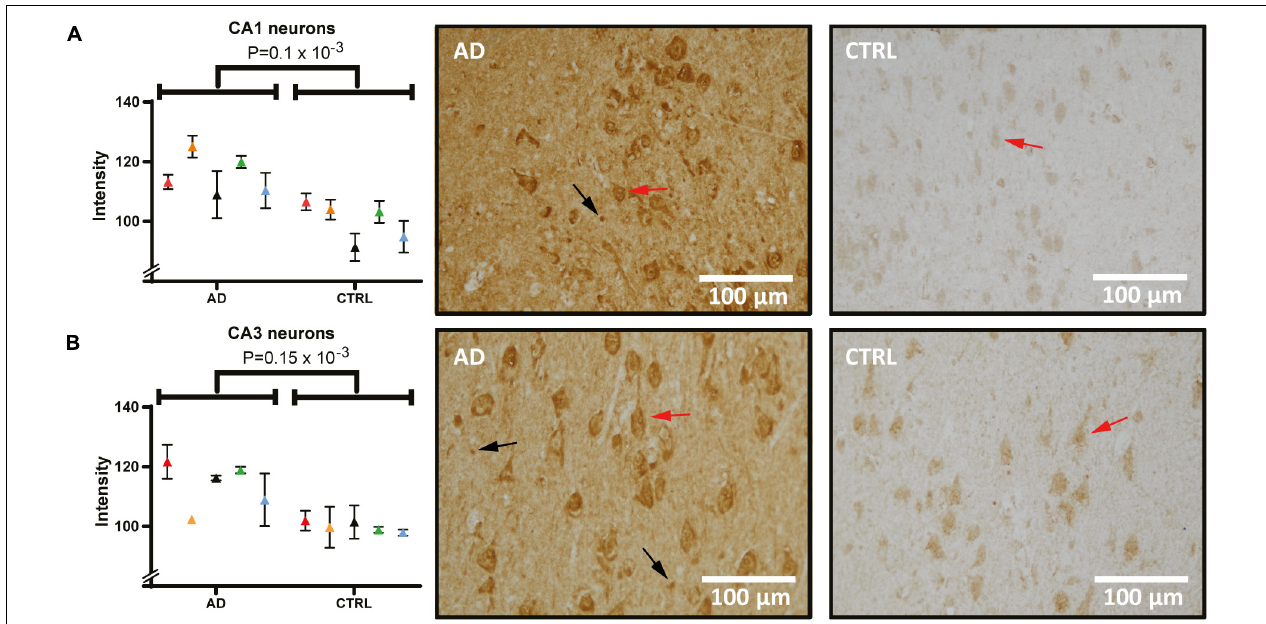
FIGURE 5 | Heat shock cognate 71 (Hsc71) levels and distribution in the hippocampus of AD and control. Panel (A) shows staining of Hsc71 in CA1 neurons quantified and compared between AD and controls (individual patients are indicated by colors in the graph) and tissue examples from one AD and one control case. Panel (B) shows staining intensity in quantified CA3 neurons and examples of analyzed images. Examples of pyramidal cells and glia cells are indicated by red and black arrows respectively. AD, Alzheimer’s disease; CA1, cornu ammonis